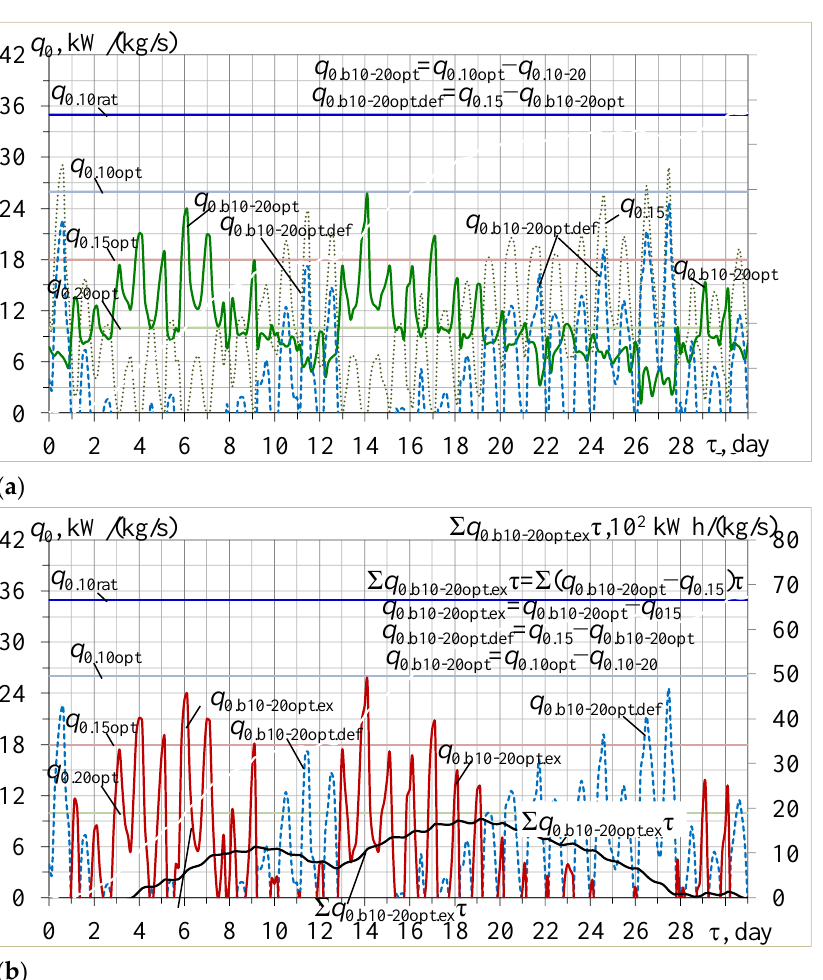
Figure 4. Optimal values of refrigeration capacities q 0.10opt , q 0.15opt and q 0.20opt for conditioning outdoor air to 10 °C, 15 °C and 20 °C accordingly; actual refrigeration capacities q 0.15 needed for preconditioning outdoor air to 15 °C; booster refrigeration capacity q 0.b10-20opt and its deficit q 0.b10-20opt.def compared to needed q 0.15 ( a ), booster refrigeration capacity exceedance q 0.b10-20opt.ex over q 0.15 and summarized monthly refrigeration energy exceedance ∑ q 0.b10 – 20opt.ex ( b ).